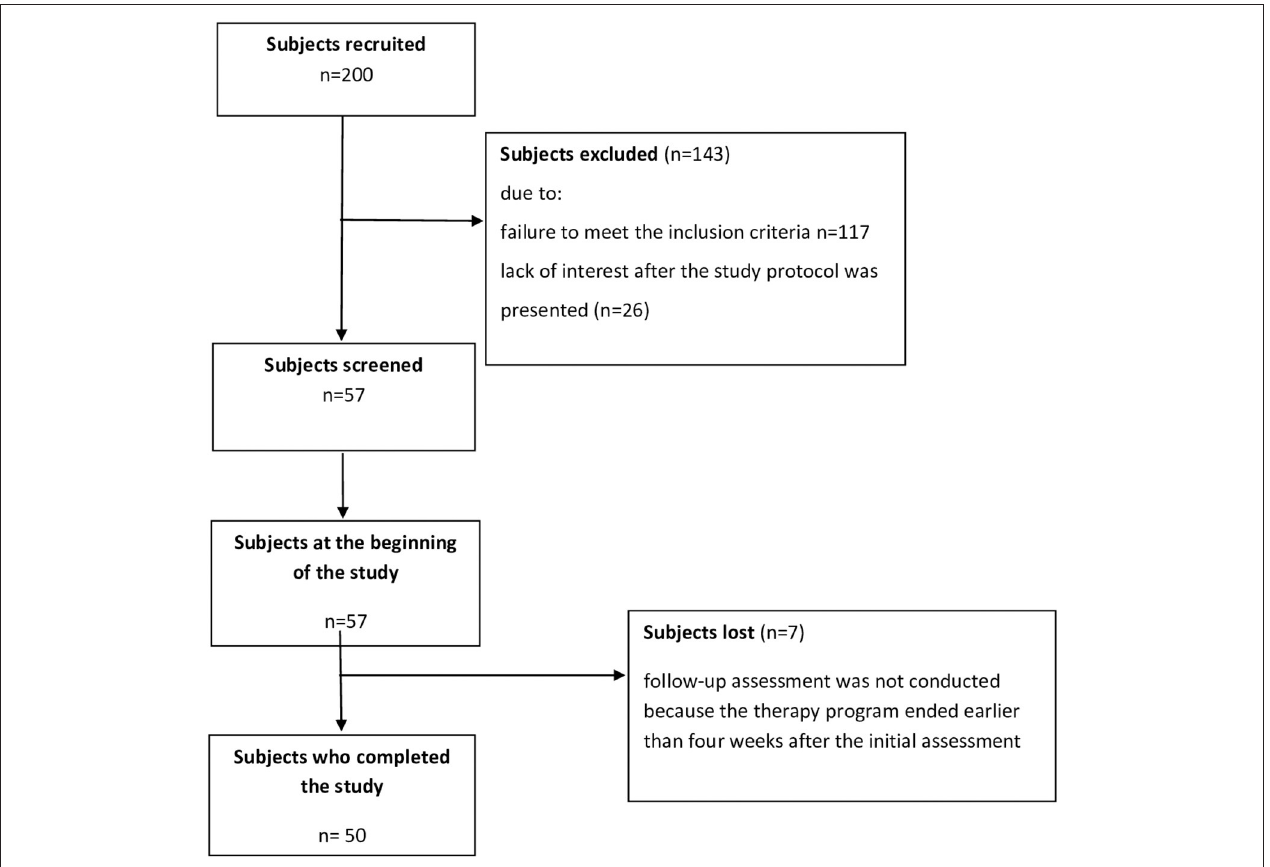
FIGURE 1 | Flow diagram relative to the enrolment of